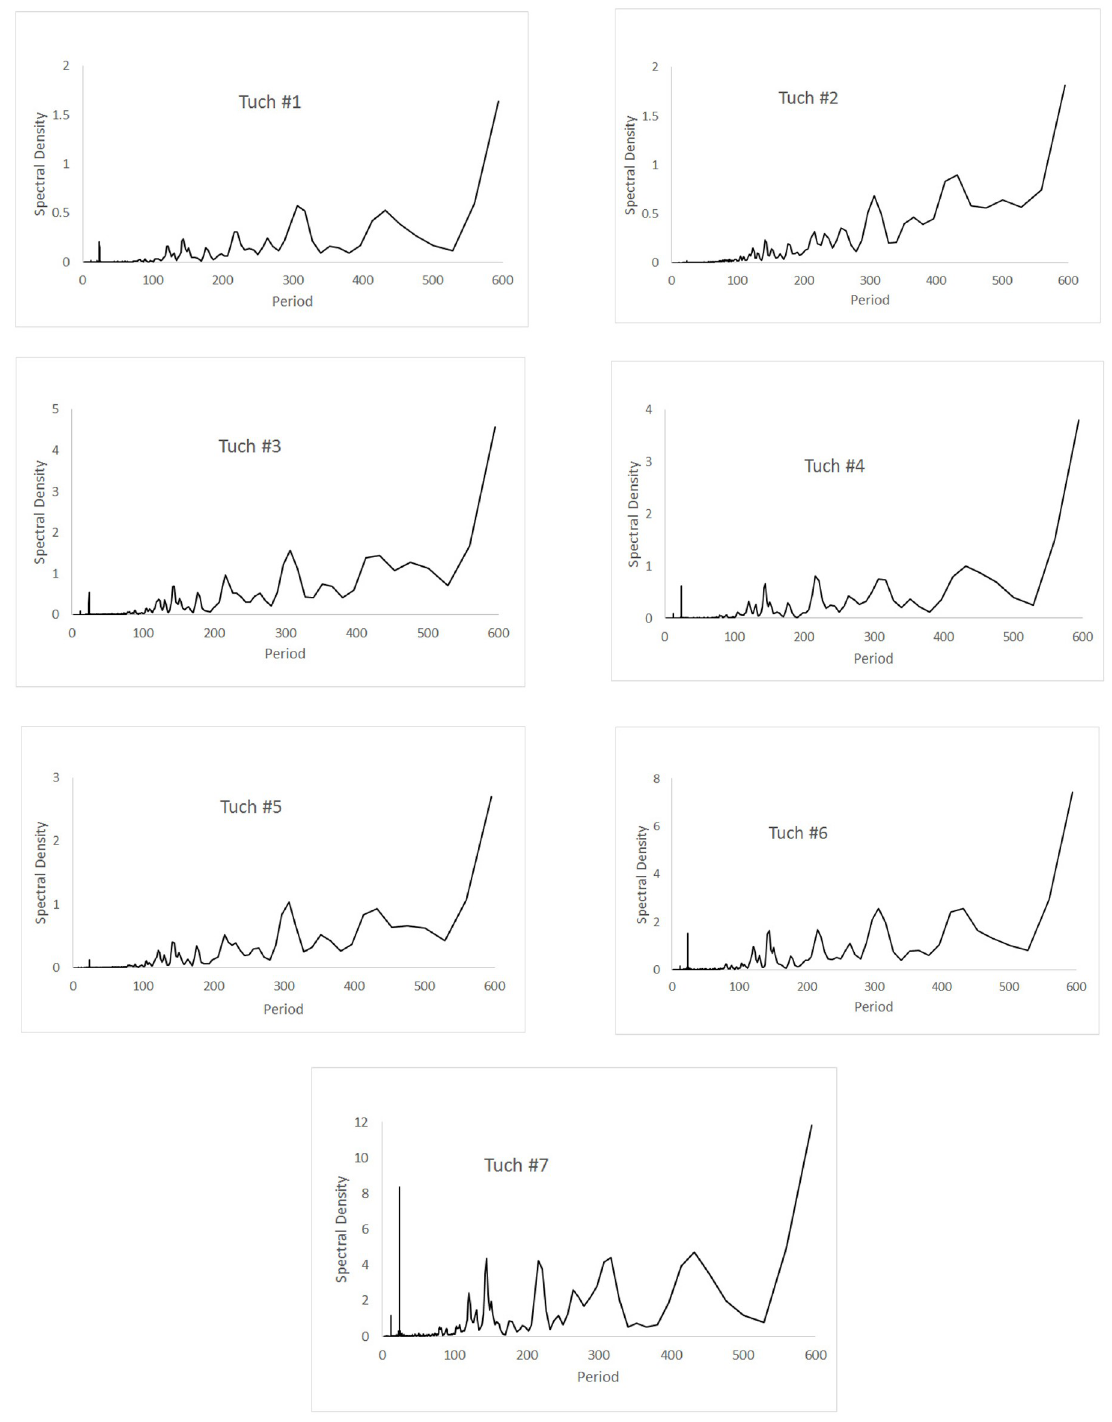
Fig 10. Spectral densities of temperature at the Rı´o Secreto (Tuch) sampling stations. Note that the scale of the y-axis is different for different stations. Period is measured in hours.